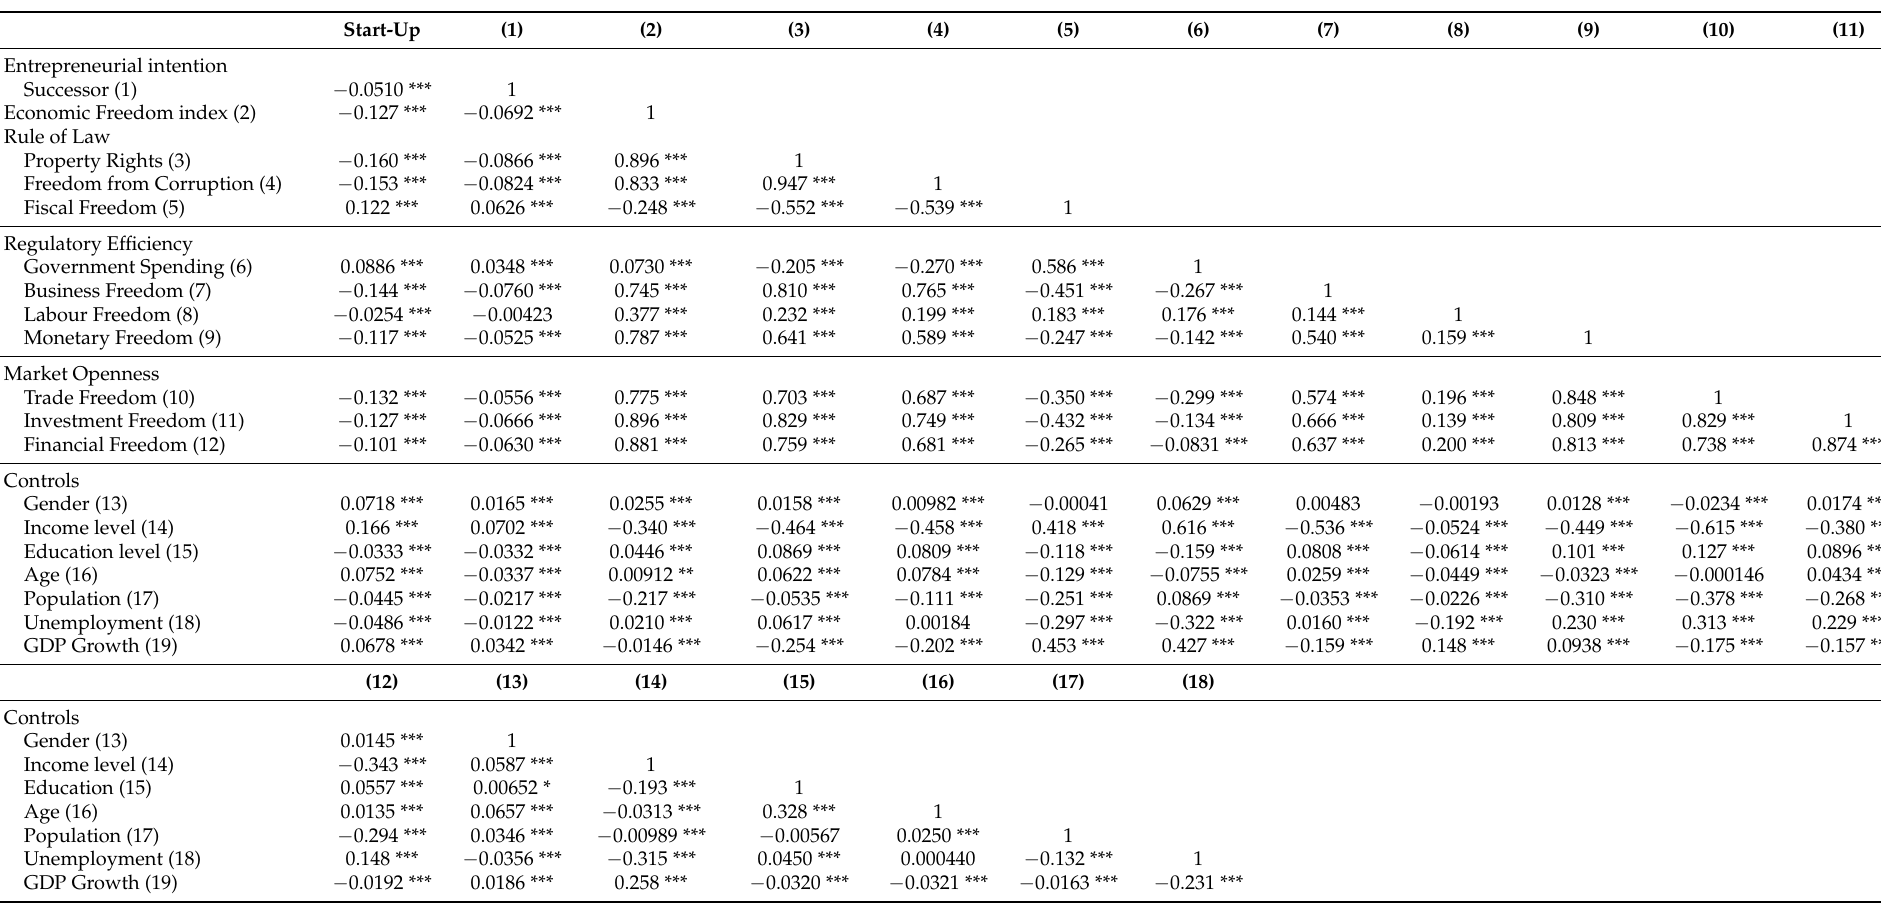
Table 3. Pairwise